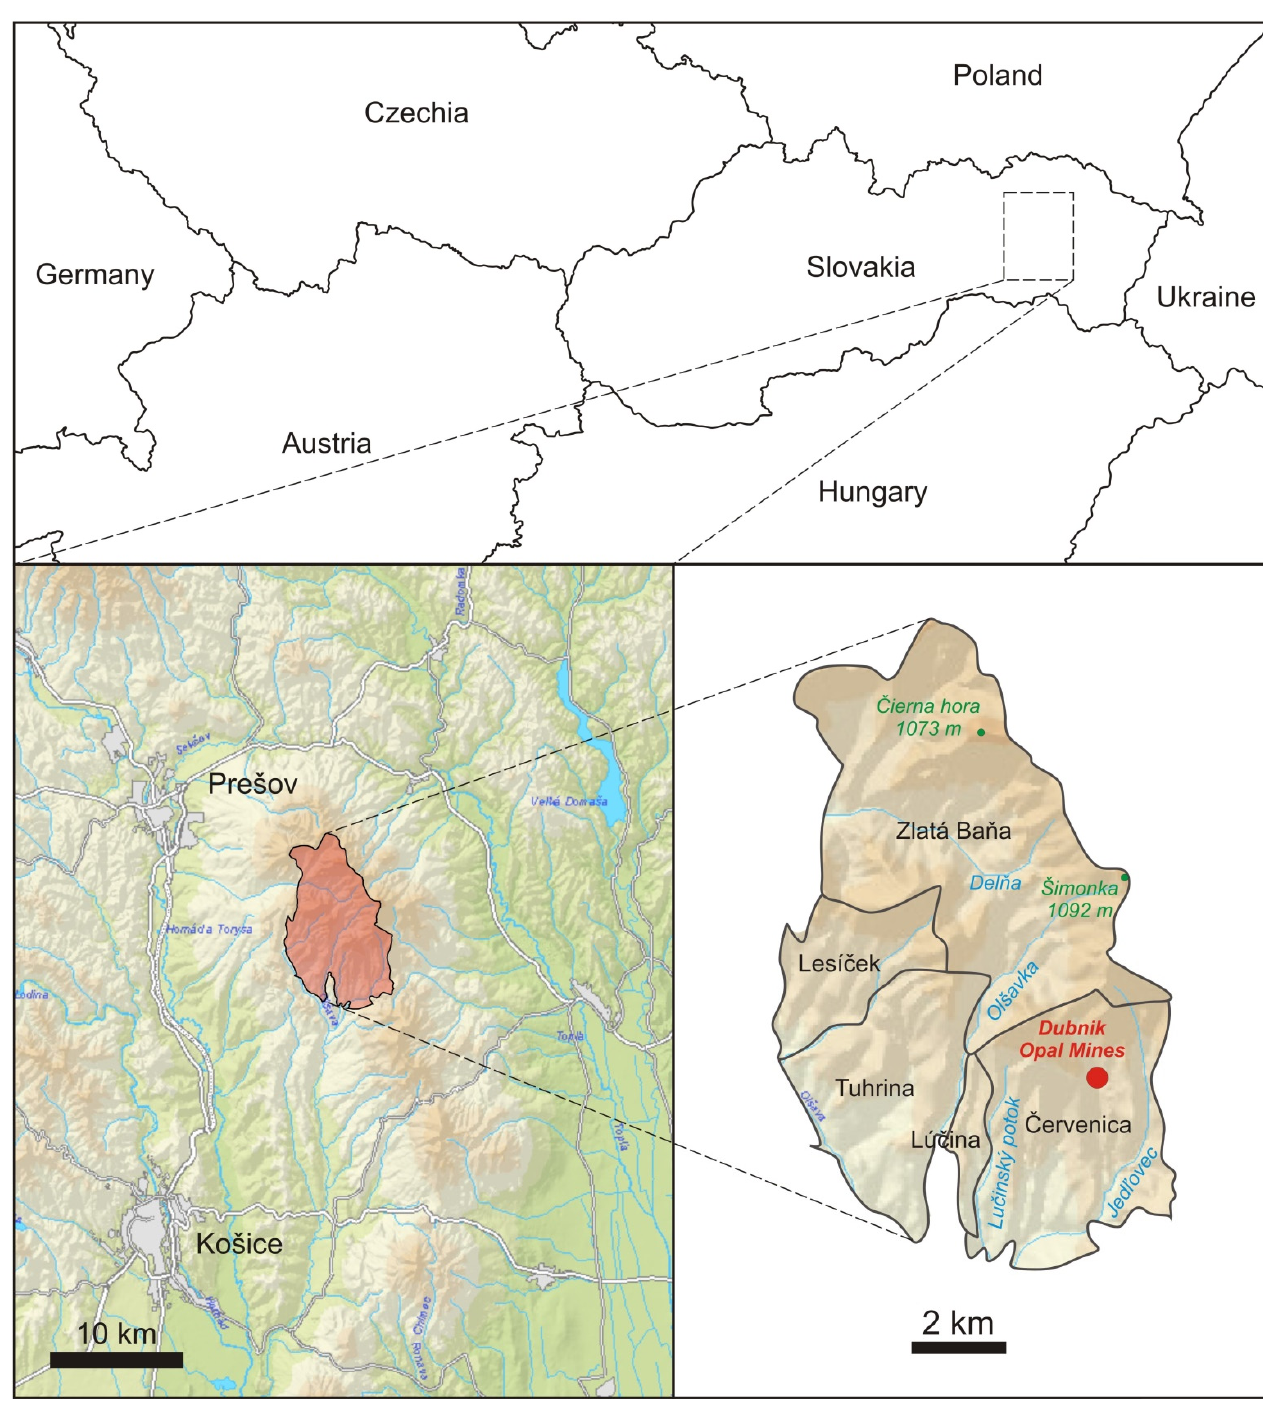
Figure 1. Localization map of the study area (shaded relief obtained from open source map server Atlas krajiny available at: https://app.sazp.sk/atlassr/ (accessed on 10 September 2022)).